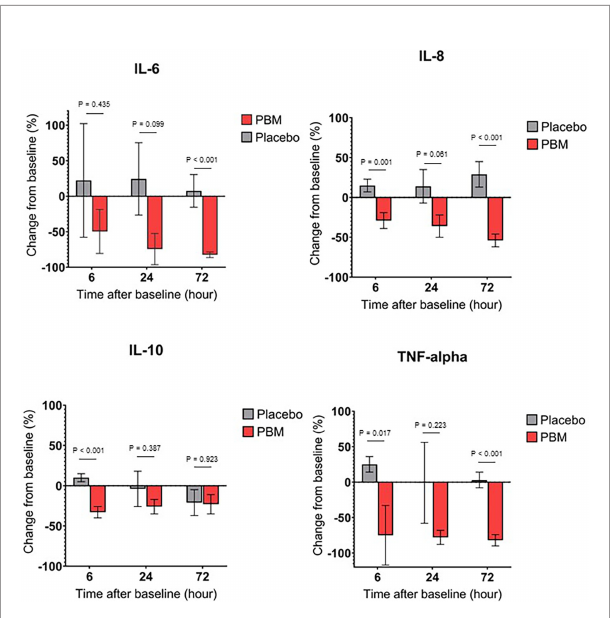
FIGURE 3 | Cytokine secretion changes over time, for Placebo and PBM groups compared to T0 (Baseline). (A) IL-6. (B) IL-8. (C) IL-10. (D)